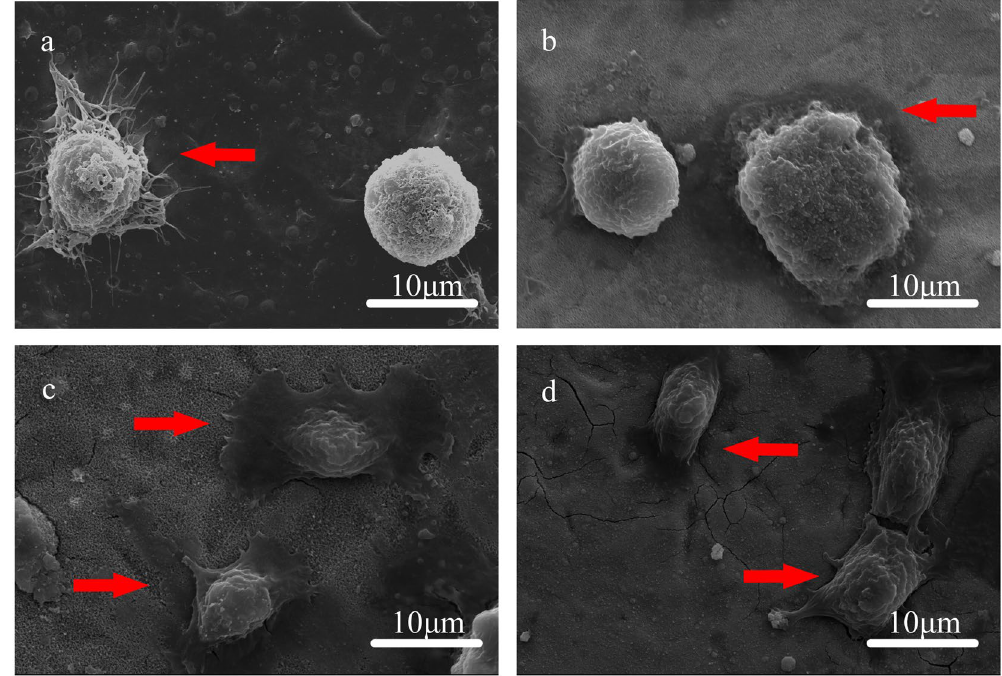
Figure 7. Initial cell adhesion after incubation for 2 h: ( a ) PT; ( b ) T-3; ( c ) T-10 and (d)